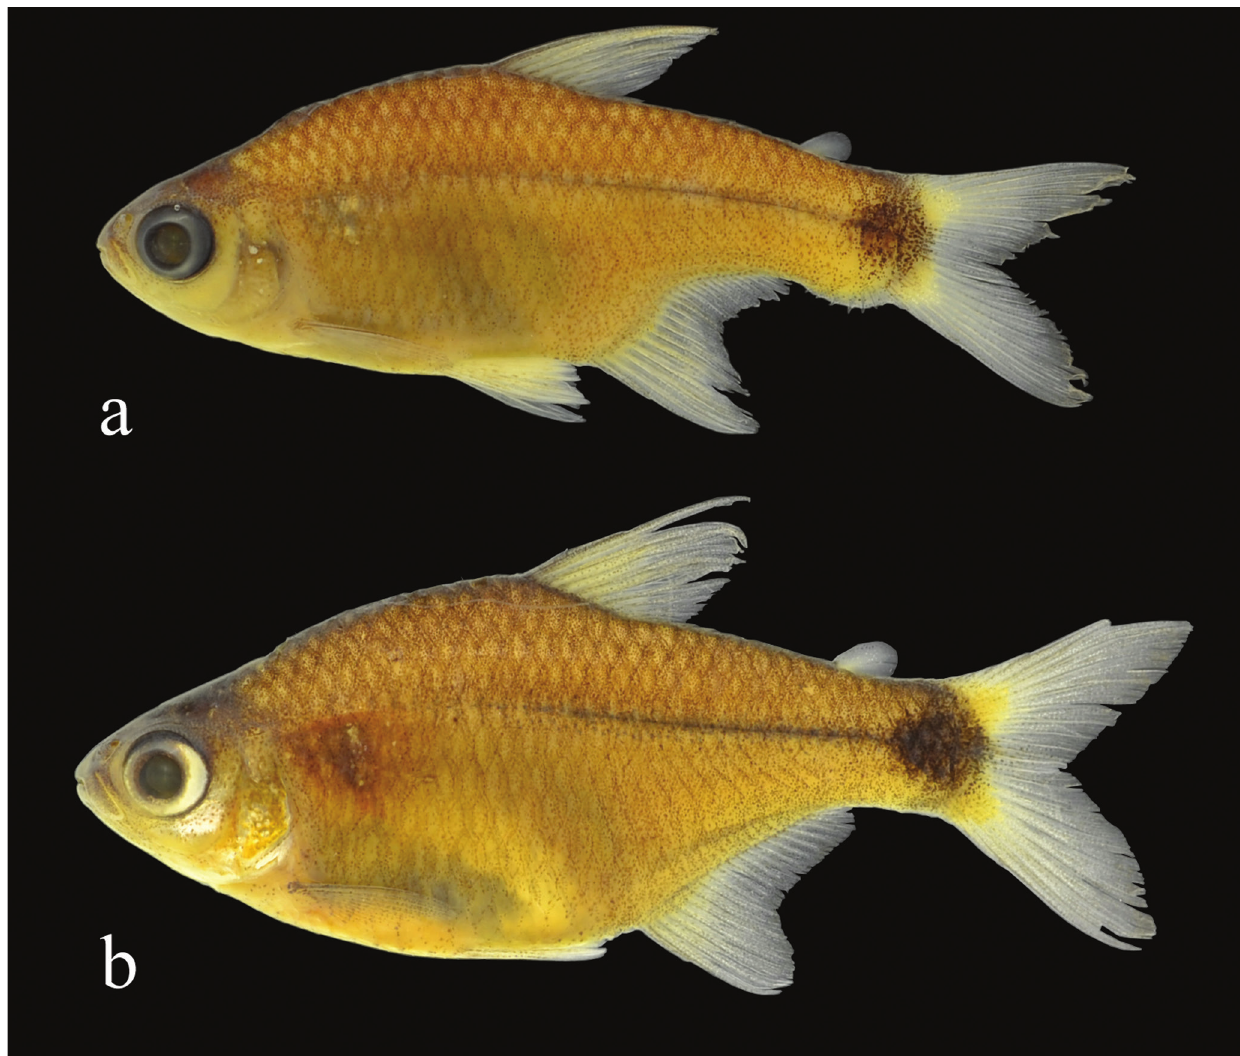
Fig. 1. Serrapinnus potiguar , ( a ) holotype, male, MCP 48054, 26.6 mm SL, rio Ceará-Mirim, district of Umari, Taipu, Rio Grande do Norte, Brazil; ( b ) paratype, female, UFRGS 9226, 29.7 mm SL, same data as